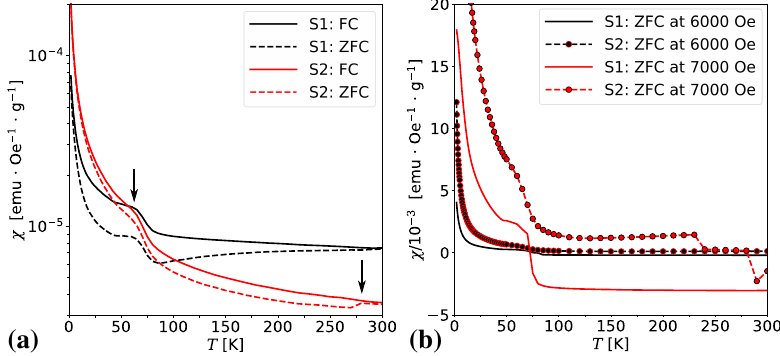
Figure 7. Temperature dependence of Zero Field Cooled/Field Cooled (ZFC/FC) magnetic susceptibility at 100 Oe for samples S1 and S2 ( a ), and temperature dependence of ZFC magnetic susceptibility at large values of the magnetic field, B = 6000 Oe and 7000 Oe ( b ). The arrows in ( a ) suggest the change of the type of magnetic response to the applied magnetic